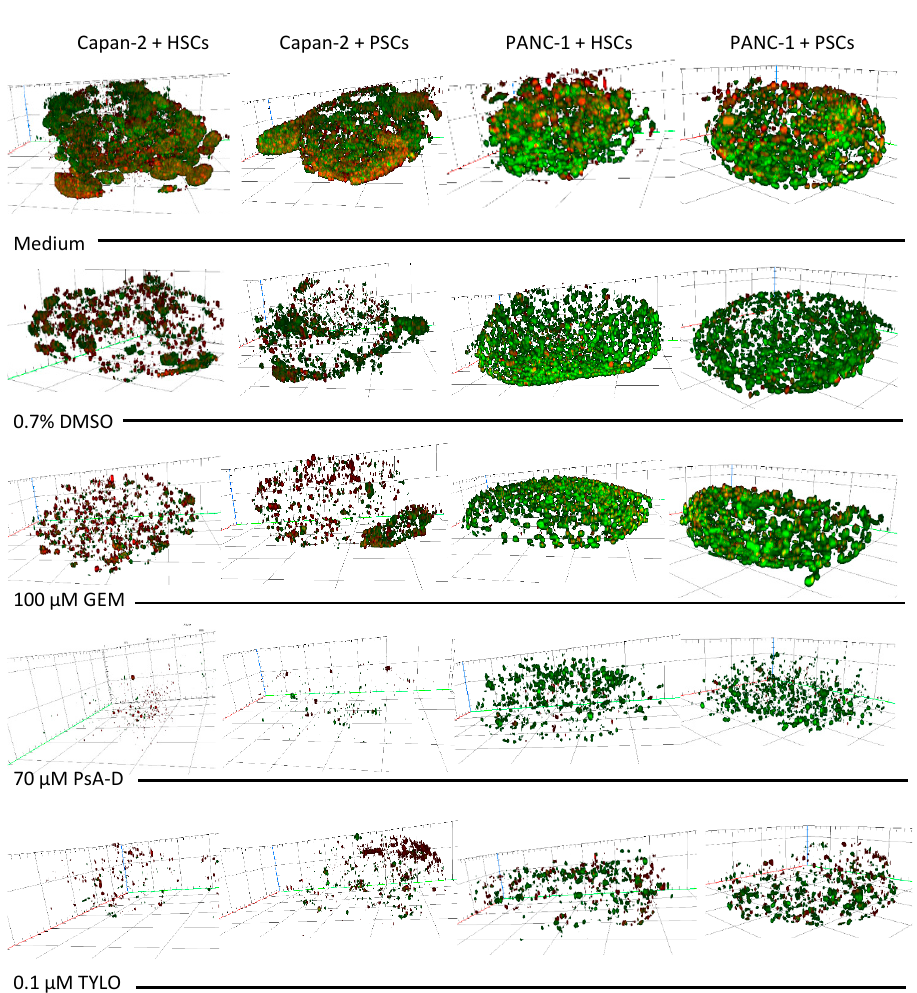
Figure 7. Three-dimensional rendering of the spheroids to examine the cell distribution following the exposure to test agents. Spheroids with 500 cancer cells (Capan-2 or PANC-1) and 1000 hepatic stellate cells (HSCs) or pancreatic stellate cells (PSCs) in 50 µ L of 0.1 mg / mL human type I collagen were grown for 4 days and then treated with 100 µ M gemcitabine (GEM), 70 µ M pseudopterosin A-D (PsA-D), 0.1 µ M O -methyltylophorinidine (TYLO), or 0.7% DMSO as a solvent control and compared to the media addition. After 3 additional days, the spheroids were fixed in paraformaldehyde (PFA) and stained for p53 (green) and Ki-67 (red). Confocal laser scanning microscopy was performed using a 10 × objective lens, with image analysis and 3D rendering performed using Zen 2.3 (blue edition). Images are representative of the two independent experiments with three spheroids in each experiment. Scale bars of X, Y, and Z axes: 100 µm.